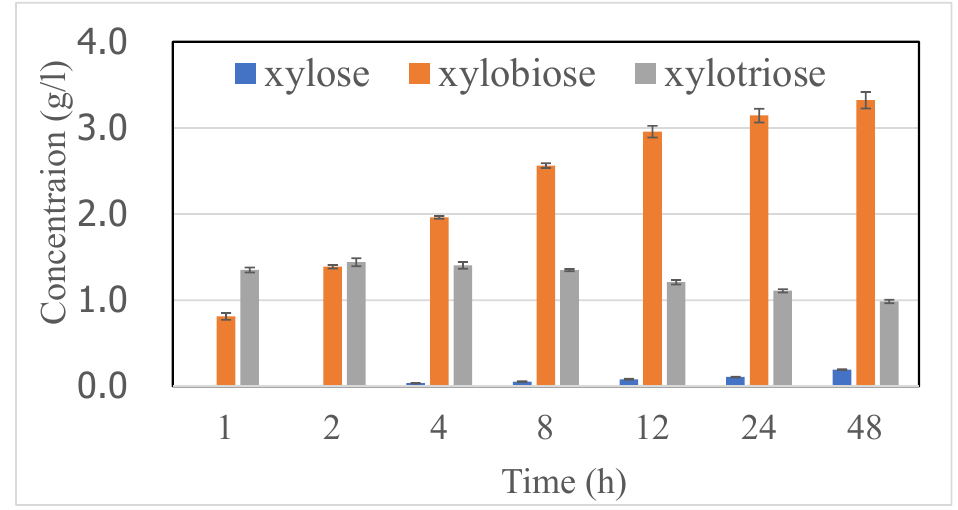
Figure 2. Time course of XOS production from EFB when using the recombinant endo-1,4- β -xylanase Xyn45. The enzyme dose was 0.5 U/mL. Each error bar represents the standard deviation of triplicate experiments.